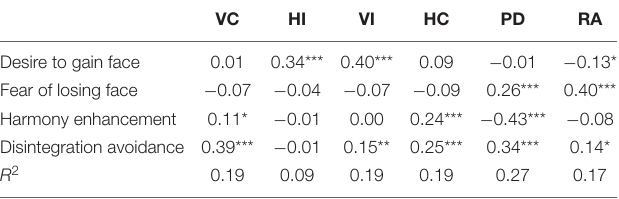
TABLE 1 | Results of the regression